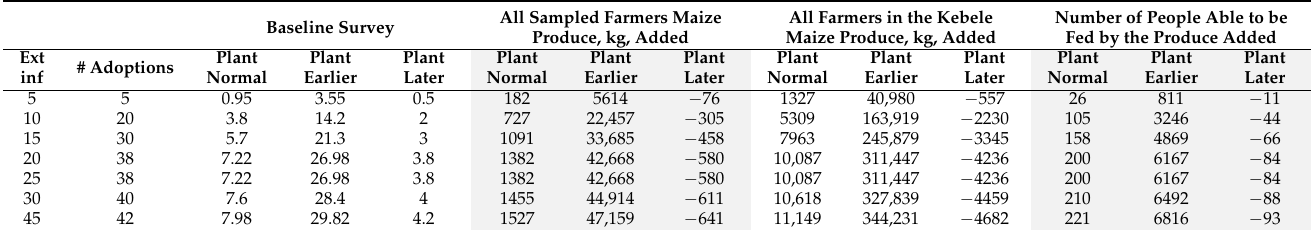
Table A9. Adoption rate of farmers’ interactions with agriculture extension workers, crop productivi- ties of adopted numbers, and number of people able to be fed under more rain conditions.